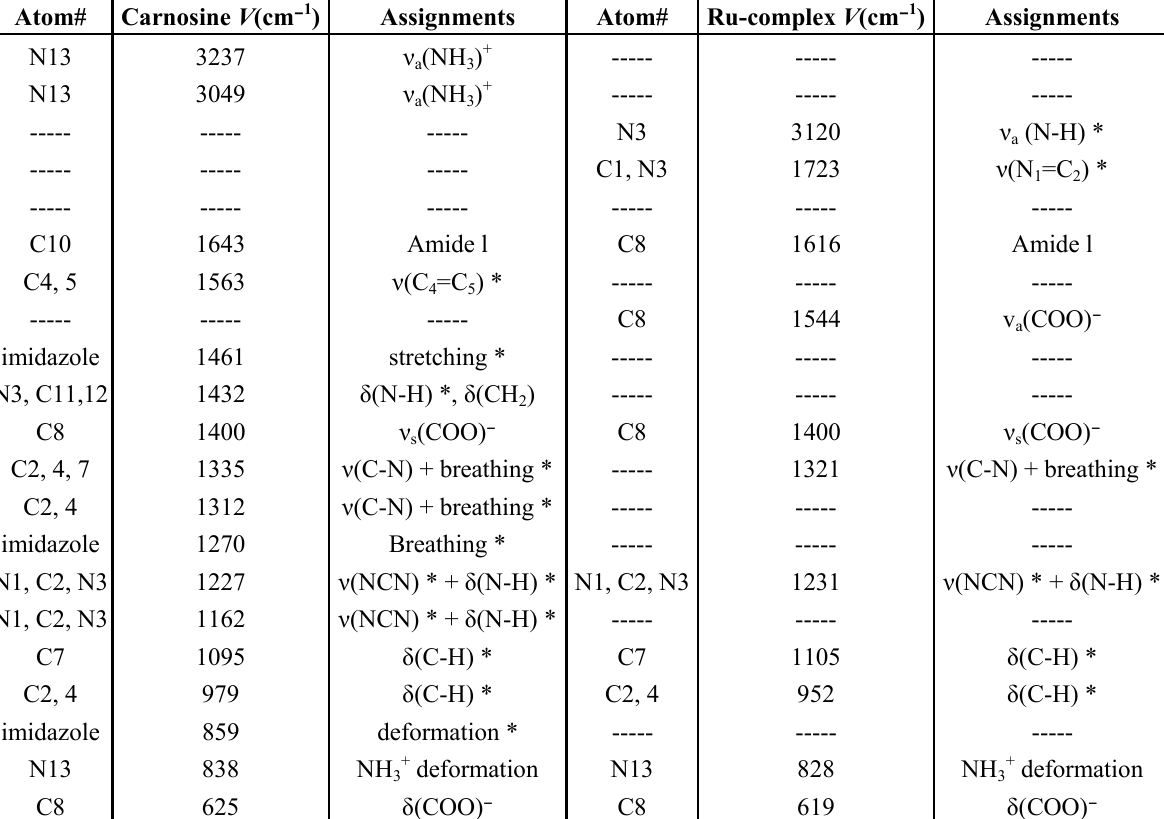
Table 3. Infrared vibration assignments for L -carnosine and Ru-carnosine complex.